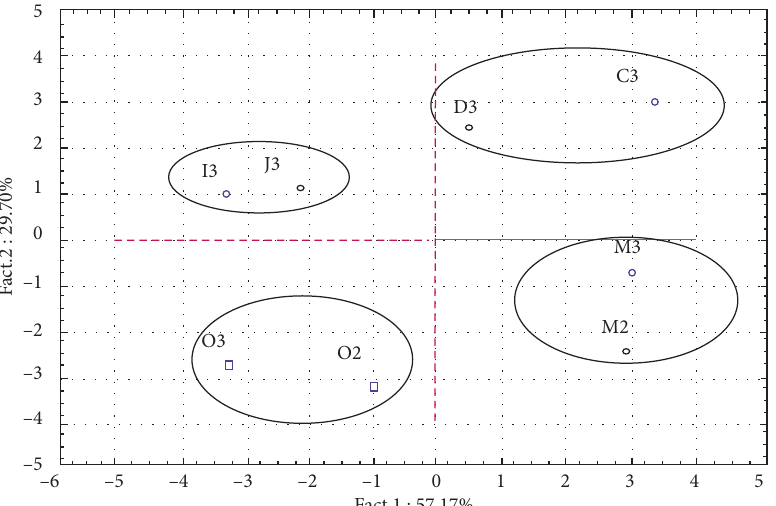
Figure 4: Factorial analysis of DGGE profile of green and husk coffees coming from four Cameroonian cities. Dschang (I3, J3); Bafoussam (D3, C3); Bafia (M2, M3); Batouri (O2, Table 3: OTA contents of the different samples of coffee analyzed. Site